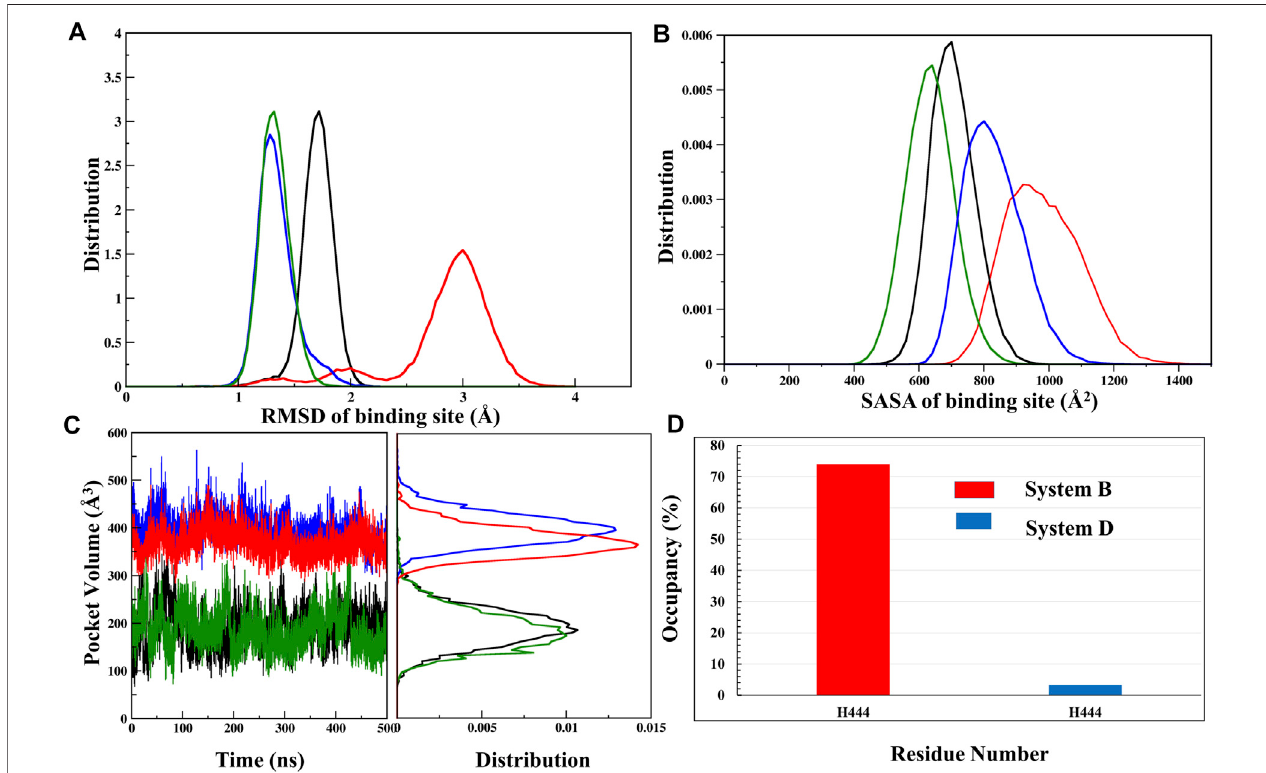
FIGURE5| Analysisofbindingsite. (A) TheRMSDdistributionplot, (B) SASAdistribution,and (C) pocketvolumeforthebindingsiteofSystemA(black),SystemB (red), System C (green), and System D (blue) were shown throughout the MD trajectory. (D) The occupancy plot of residue H444 forming the water bridge interaction (wHB) with the ‘ OCA ’ is shown in Systems B and